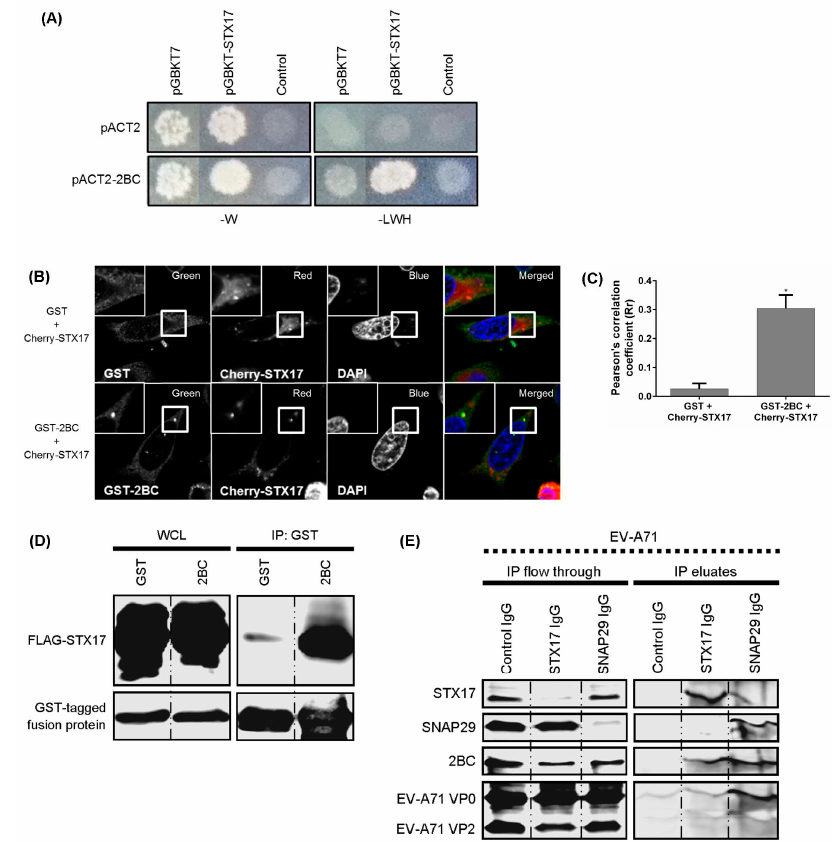
Figure 5. The 2BC non-structural protein of EV-A71 interacts with syntaxin-17 (STX17) and synaptosome-associated protein of 29 kDa (SNAP29). ( A ) Yeast two-hybrid assays of 2BC and STX17. Yeasts were transformed with pGBKT7 or pGBKT7-STX17 together with pACT2 or pACT2–2BC. Yeasts were then grown on selective medium without tryptophan (-W) or without leucine, tryptophan, and histidine (-LWH); ( B ) HeLa cells were transfected with pDEST27 or pDEST27–2BC in combination with pCherry-STX17 for 48 h. The transfected cells were examined under a confocal microscope with objective 63× (scale bar 10µm) for the presence of co-localization; and ( C ) the Pearson’s correlation coefficient was determined; ( D ) HEK-293T cells were co-transfected with FLAG-STX17 and GST-2BC for 48 h. Lysates were collected for co-immunoprecipitation (IP) using glutathione (GST) sepharose. Western Blot was performed to detect FLAG-STX17 and GST fusion proteins; ( E ) RD cells were infected with EV-A71 for 8 hpi and lysates of infected cells were then harvested prior to co-immunoprecipitation (co-IP) assay using anti-STX17 and anti-SNAP29. The final IP eluates and discarded IP flow through were collected for WB to detect 2BC (anti-2C polyclonal antibody) and structural proteins (mAB979) of EV-A71One-way ANOVA: *** p < 0.001 and **** p < 0.0001.